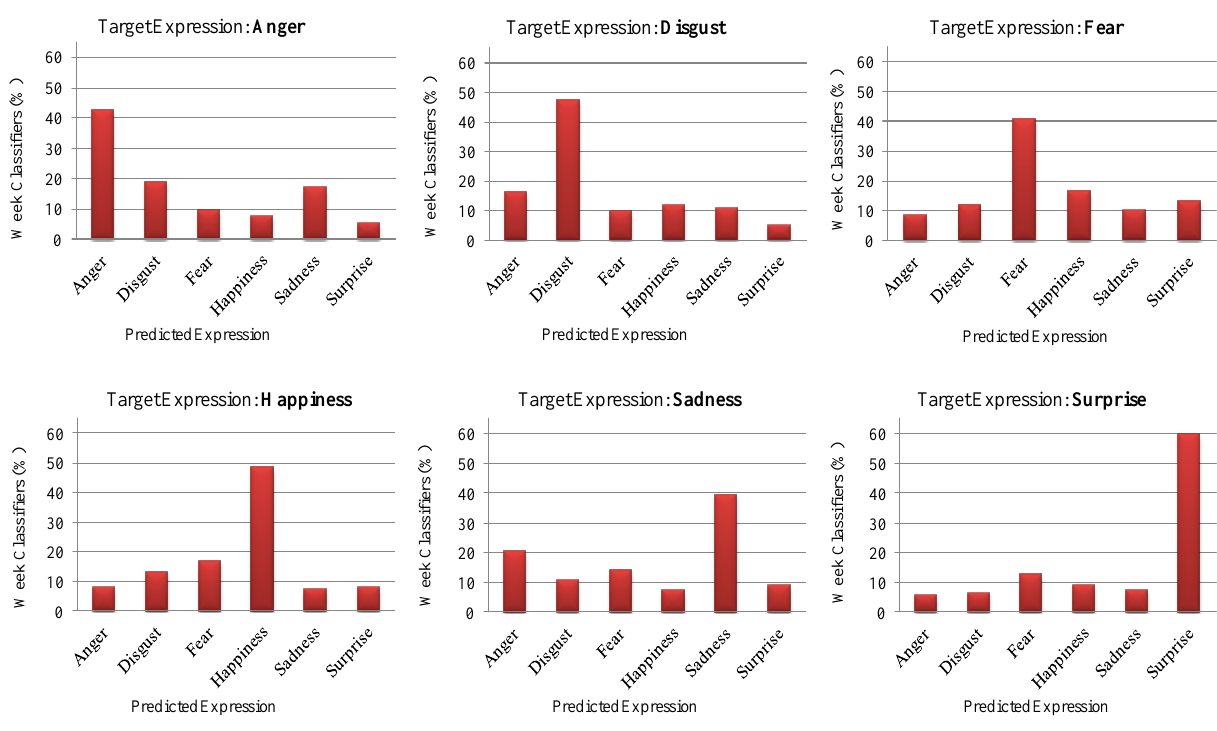
Figure 9. Average confusion score of week classifiers in percentages, for the recognition of each class of facial